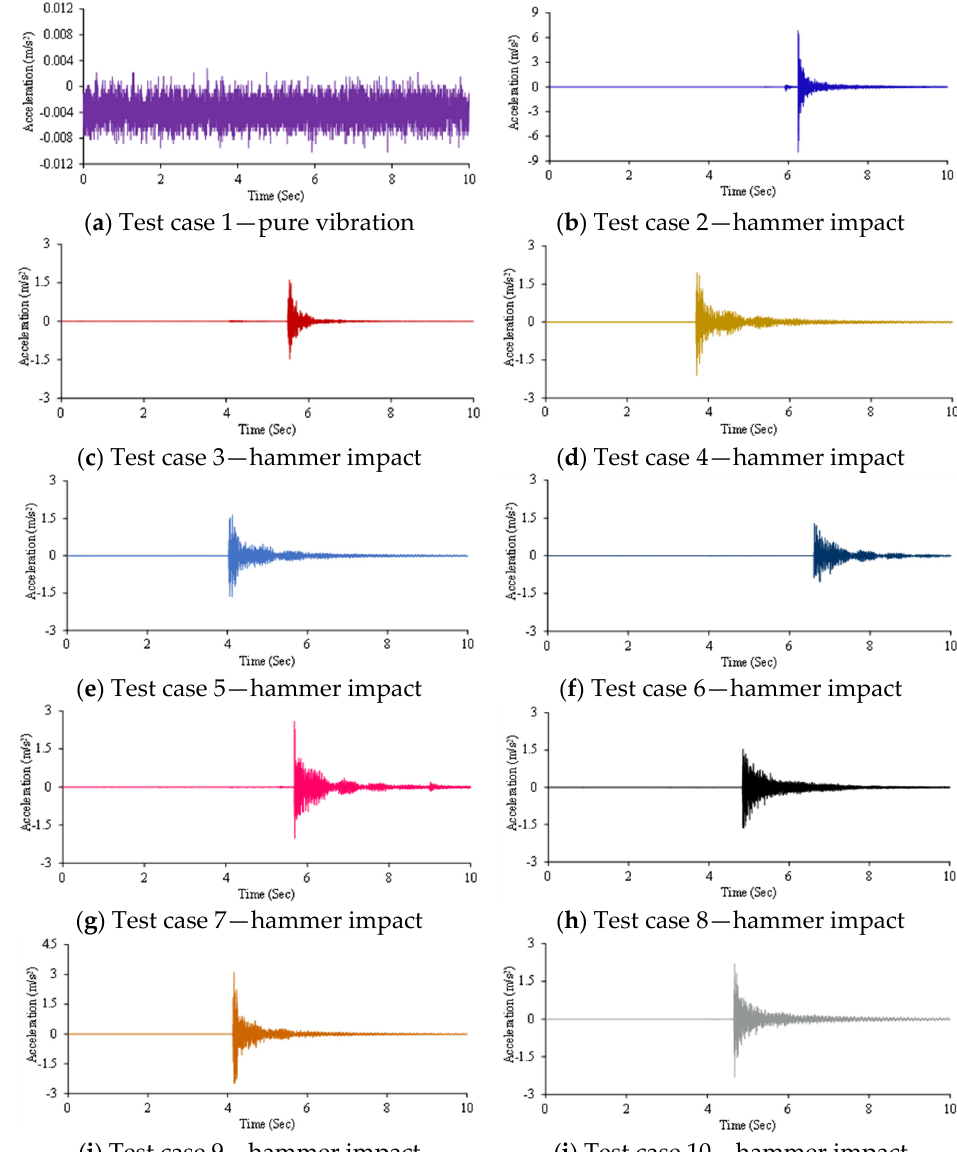
Figure 6. Time histories of response acceleration of test specimen recorded by accelerometer 3L in different test cases.